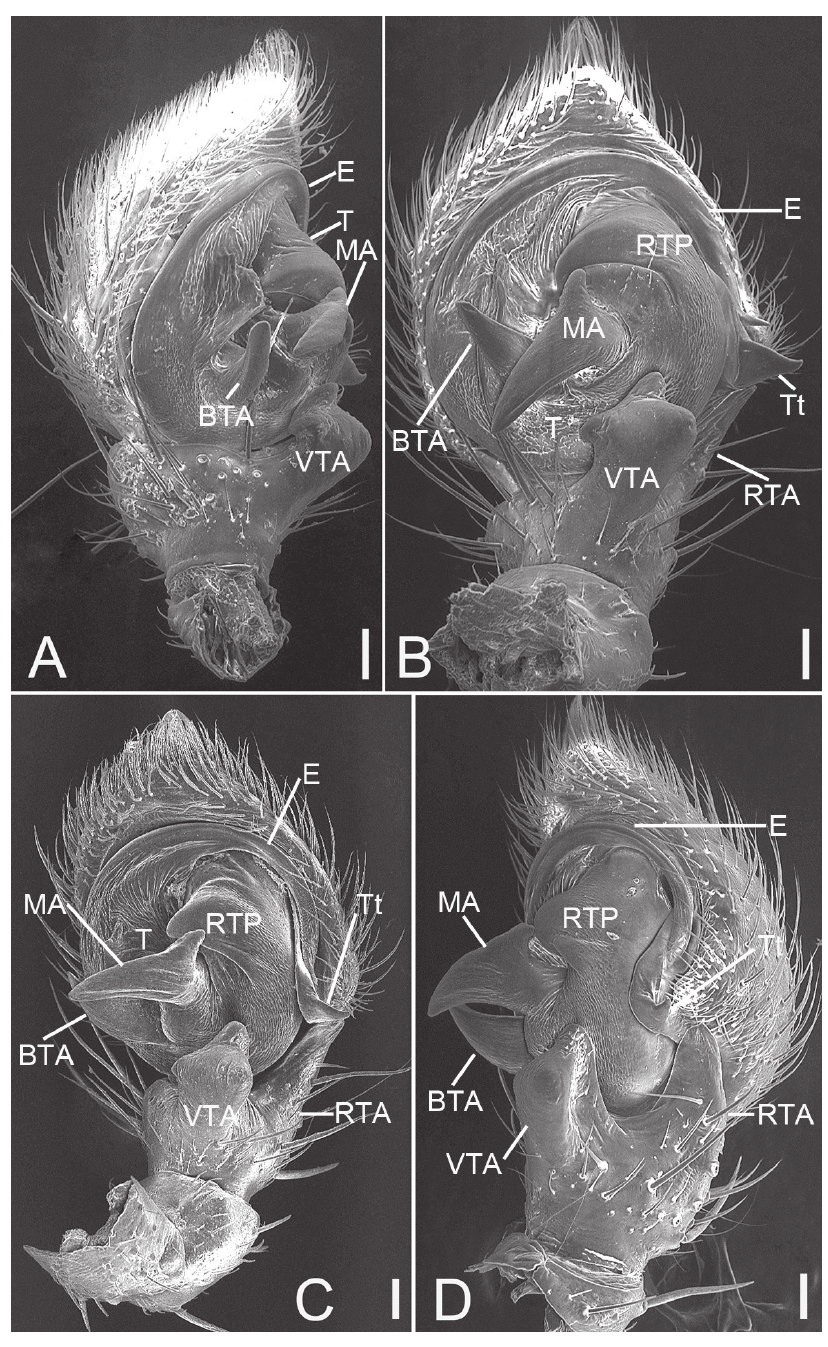
Figure 16. SEM micrographs of Xysticus lesserti Schenkel, 1963, male palp. A prolateral view B ventral view C ventral view, slightly retrolateral D retrolateral view. Abbreviations: BTA – basal tegular apophysis, E – embolus, MA – median apophysis, RTA – retrolateral tibial apophysis, RTP – ridge-shaped tegular process, T – tegulum, Tt – tutaculum, VTA – ventral tibial apophysis. Scale bars: 0.1